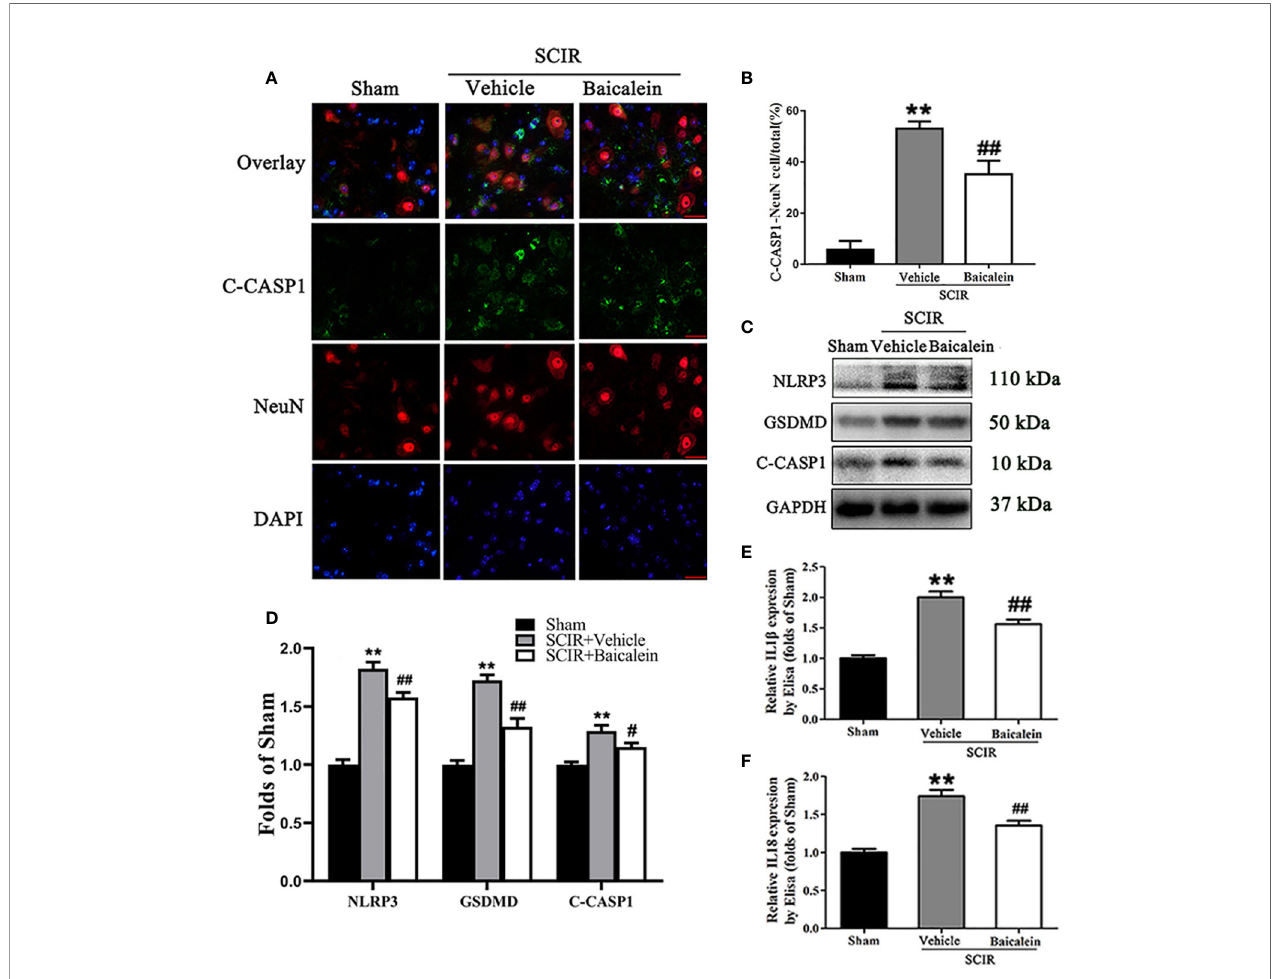
FIGURE 4 | Baicalein attenuates pyroptosis after spinal cord ischemia-reperfusion injury (SCIR). (A) Immuno fl uorescence staining for C-CASP1 and NeuN colocalization in the spinal cords of the Sham, SCIR+Vehicle, and SCIR+Baicalein groups (Scan bar= 25 m m) (B) The quantitative percentage of the C-CASP1- positive neurons at the spinal cord lesion. (C) Western blotting for NLRP3, GSDMD, and C-CASP1 expression levels in the Sham, SCIR+Vehicle, and SCIR+Baicalein groups. The gels were run under the same experimental conditions, and the cropped blots are shown here. (D) The optical density values of the NLRP3, GSDMD, and C-CASP1 expression levels were quanti fi ed and analyzed in each group. (E, F) Enzyme-linked immunosorbent assay (ELISA) results for IL1 b and IL18 expression levels in the Sham, SCIR+Vehicle, and SCIR+Baicalein groups. The values are expressed as the means ± SEM, n=5 per group. ** p < 0.01, vs. Sham group. # p < 0.05 and ## p < 0.01, vs. SCIR+Vehicle